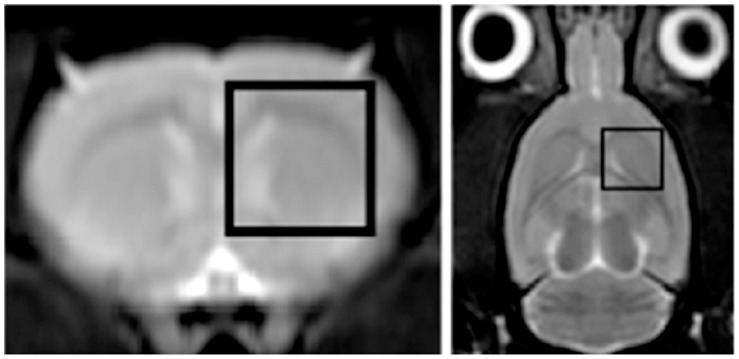

1H-MRS voxel on the nucleus striatum.Coronal and axial T2-weighted Turbo Spin Echo (T2-TSE) images of the rat brain showing a 5×5×5 mm3
1H-Magnetic Resonance Spectroscopy (1H-MRS) voxel (delimited by the white perimeter) centered on the nucleus striatum.